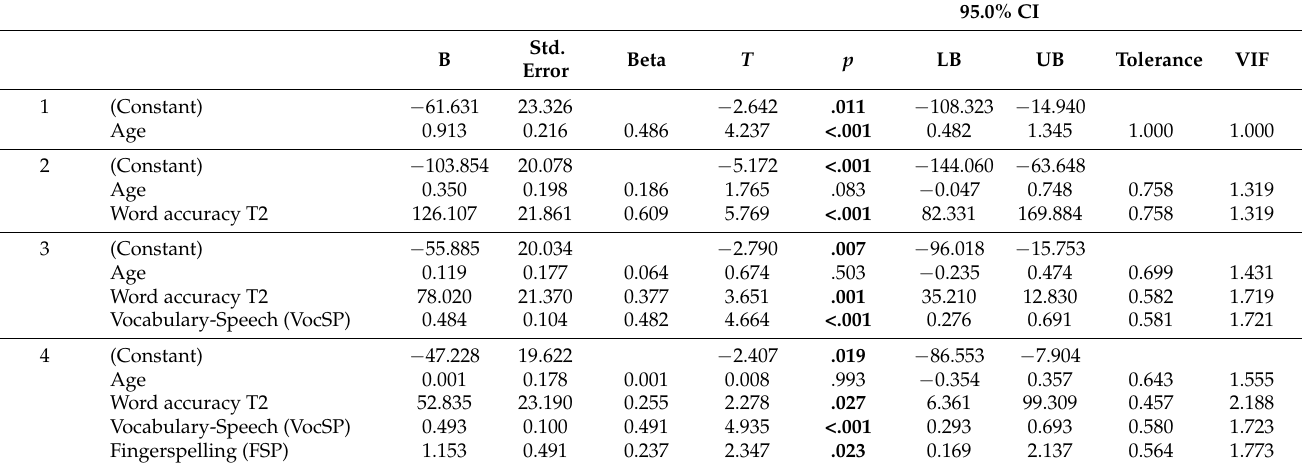
Table 9. Regression coefficients for text fluency at T3. Significant predictors are